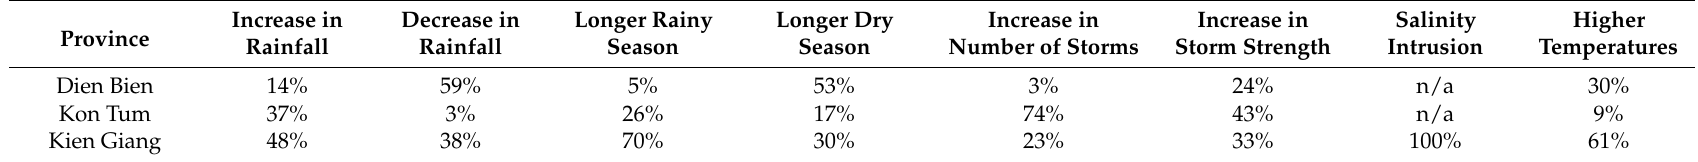
Table 3. Household perceptions of weather and climate changes in recent years (% of households citing each